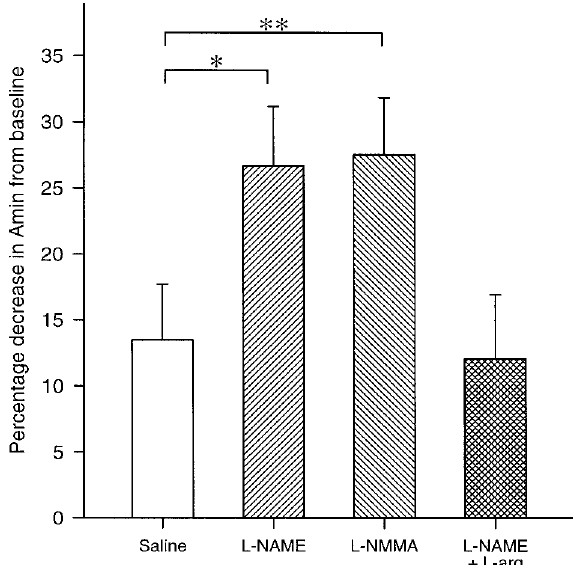
FIG. 4. The percentage decrease in the minimal cross- sectional area of the nasal airway (A min ) from baseline 10min after challenge with histamine, 200 m g. The nasal cavity was pretreated every 30min with saline, a NOS inhibitor ( L -NAME or L -NMMA, 1 m mol), or L -NAME together with L -arginine, 30 m mol, for 6h prior to the histamine challenge. Data are means± SEM from 10 subjects. **,*Sig- nificant increase in the histamine-induced percentage change in A min following pretreatment with a NOS inhibitor compared to saline pretreatment (*,** P <0.05 and P <0.01, respectively, Wilcoxon sign-rank